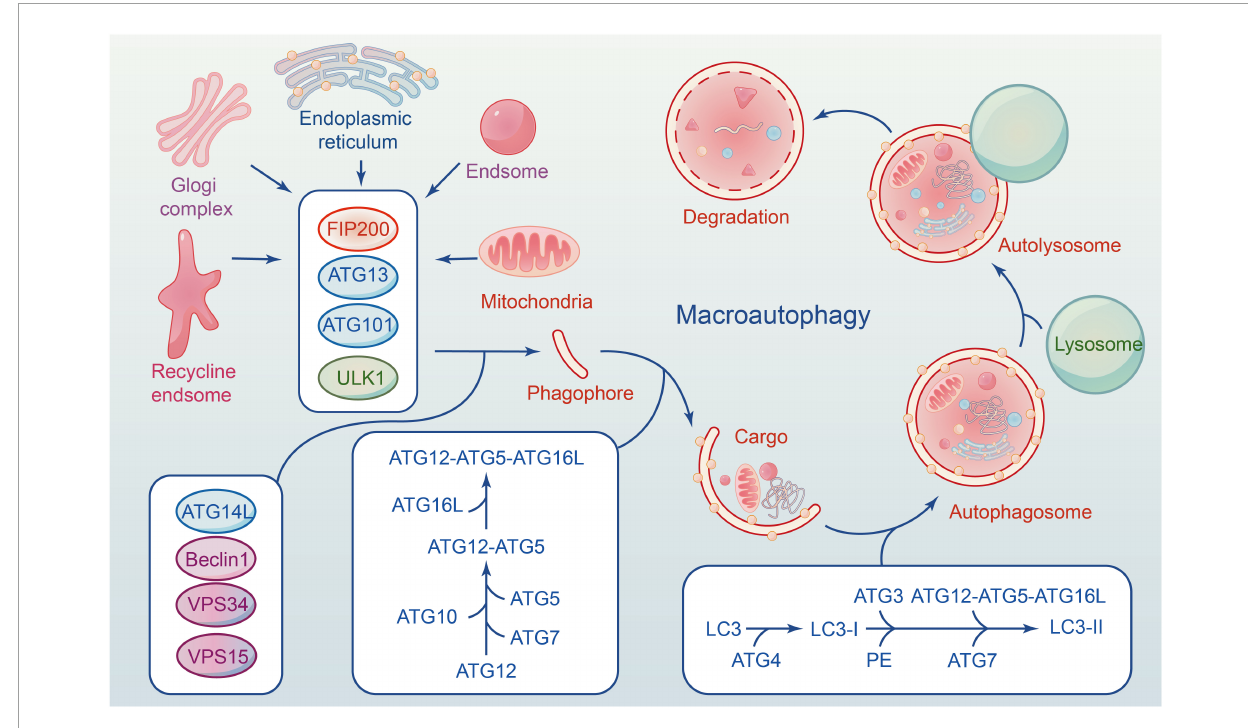
FIGURE1 The formation of macroautophagy process and ATG proteins in mammalian cells. ULK1 complex involves in the induction of phagophores formation, and Beclin-1–Vps34 complex to enhances phagophores nucleation. Elongation of the autophagosome is mediated by two conjugated systems comprising ATG12– ATG5–ATG16L, and LC3–PE. After formation of complete autophagy vesicles, the mature autophagosome becomes fused with a lysosome to create an autolysosome, where sequestered molecules and organelles are degraded.